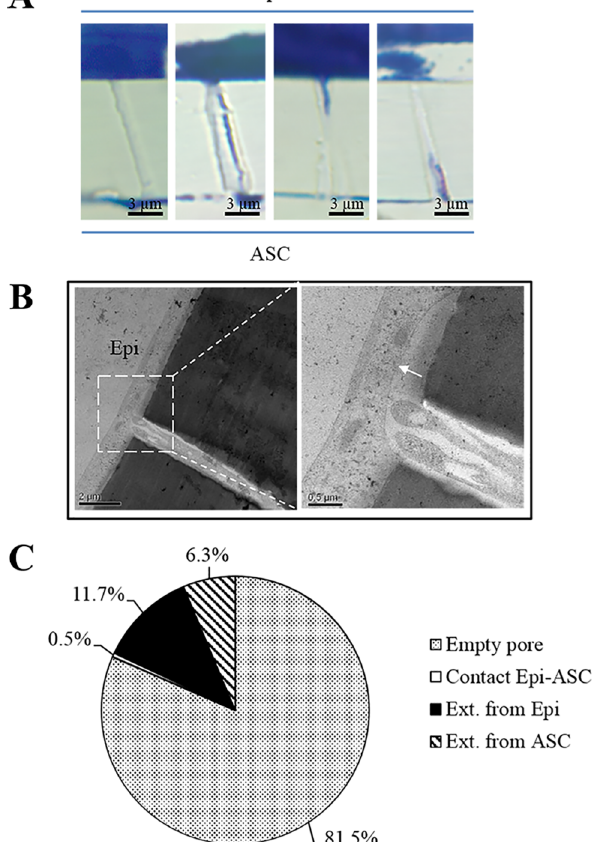
Fig 8. Few cell-cell contacts between the epithelial cells and the ASC feeder cells in 3D CC-ASC culture. (A) Representative images showingan empty pore, a pore with possiblecell-cellcontact, a pore with no cell-cellcontact but with cell extensionfrom the epithelialcells, and a pore with no cell-cellcontact but with cell extensionfrom the ASC feeder cells, respectively. (B) An image showingthe cell-cellcontact between LSCs and ASC feeder cells using electron microscopy. White arrow indicatesthe interface of cell-cellcontact. (C) Percentages of pores with empty content, cell-cellcontact, no contact but with cell extensionfrom epithelialcells, and no contact but with cell extensionfrom ASC feeder cells in the 3D CC-ASC culture. Epi: culturedepithelialcells. Scale bar = 3 μ m.